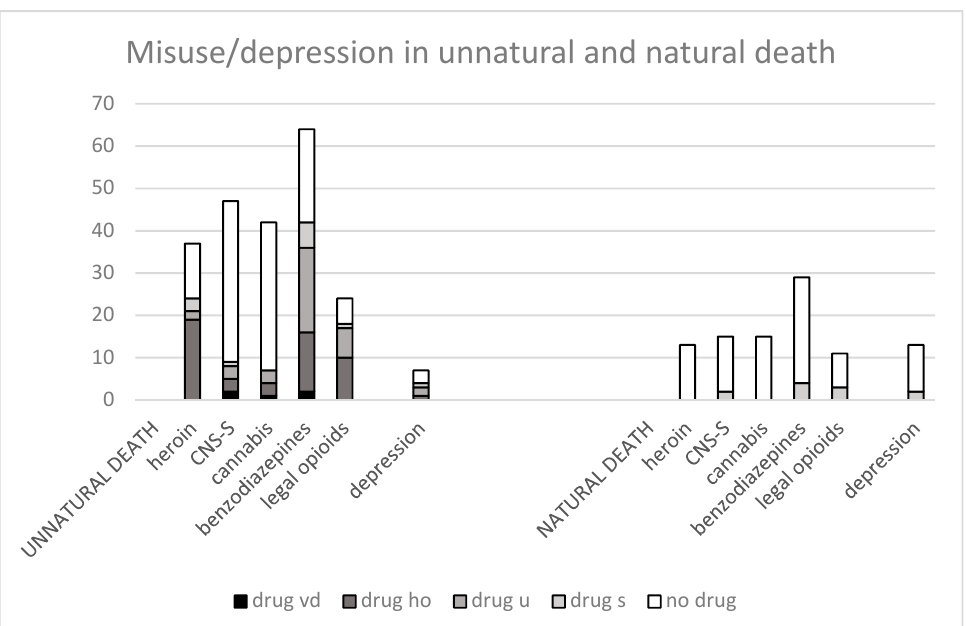
Figure 2. Autopsy findings by manner of death related to substances misused in life and previous depression; violent death (vd) heroin overdose (ho), undetermined intent (u) suicide (s), no drug. Unnatural and natural death. y-axis, number of cases.